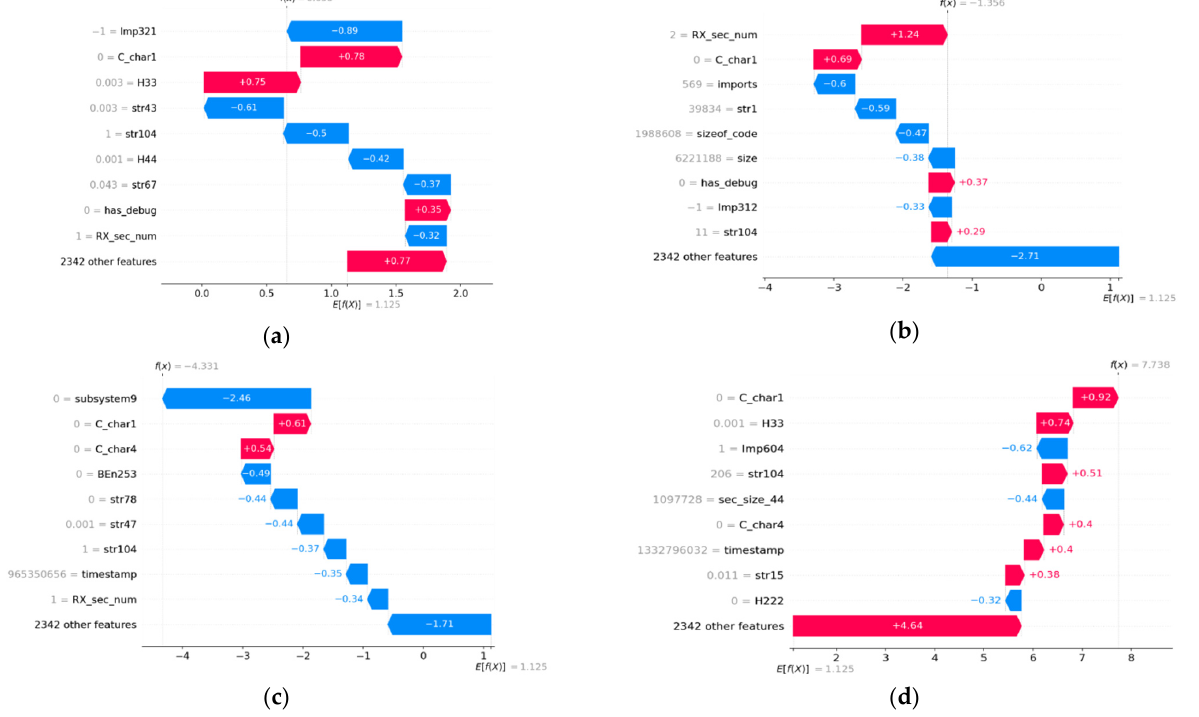
Figure 6. Waterfall plot of a FP sample ( a ), a FN sample ( b ), a TP sample ( c ), and a TN sample ( d ) ( d ) from the D2 dataset in shap value.